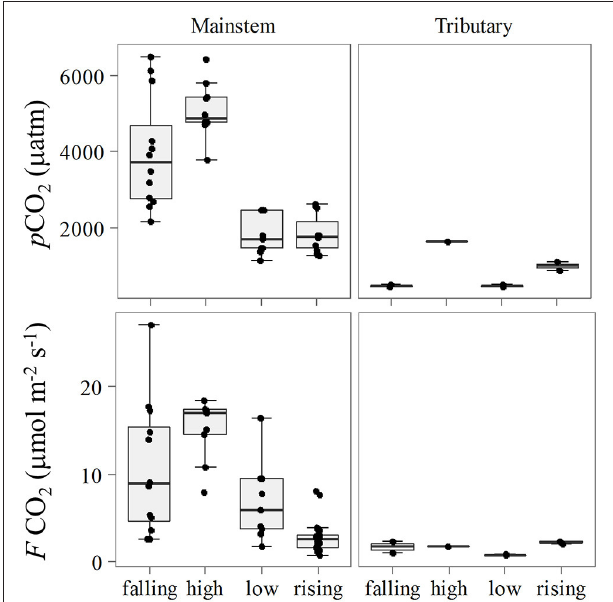
FIGURE 3 | Seasonal variation of p CO 2 and F CO 2 for the mainstem and